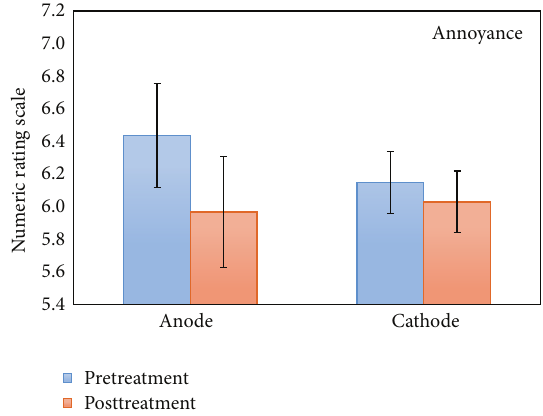
Figure 4: NRS annoyance pre- and posttreatment (anodal and cathodal) for the 2.0 mA